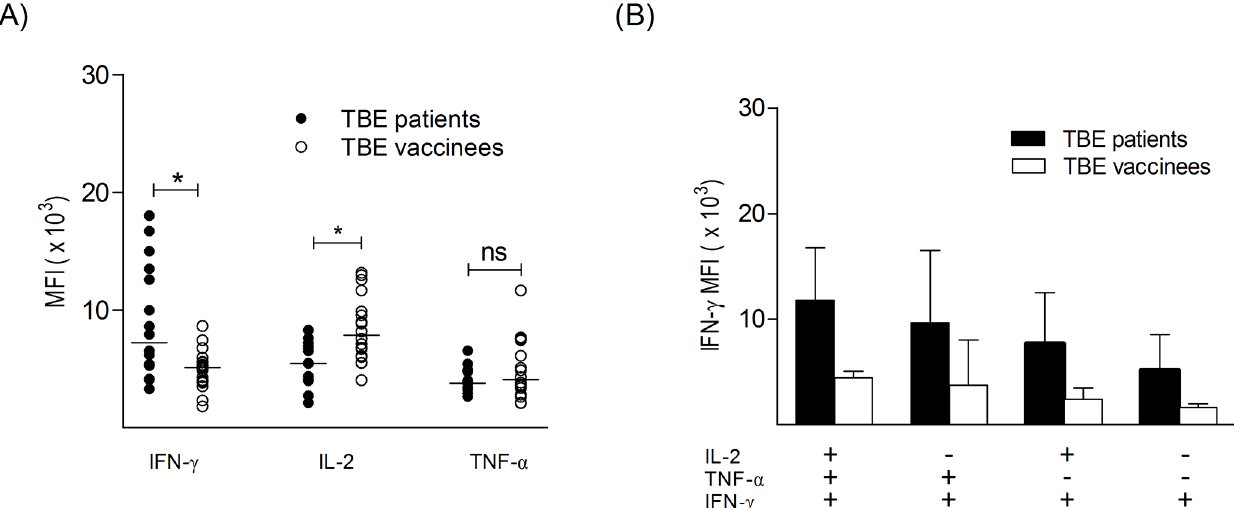
Fig 2. TBEV-specific polyfunctional CD4 + T cells from TBE patients and booster vaccinated persons express different amounts of IFN- γ . (A) Median fluorescence intensity (MFI) of IFN- γ , IL-2 and TNF- α in triple-positive TBEV-specific CD4 + T cells from TBE patients (n = 16) and booster vaccinated persons (n = 18). Medians are indicated by black lines. Mann Whitney test was used to test for differences between patients and vaccinated groups. (B) MFI (mean + standard deviation) of IFN- γ in IFN- γ + subtypes (TNF- α + IFN- γ + IL-2 + ; TNF- α + IFN- γ + ; IFN- γ + IL-2 + and single IFN- γ + ) from subjects who mounted detectable responses with all 4 IFN- γ subtypes (8 TBE patients and 4 booster-vaccinated subjects). (for individual data, S4 Table).